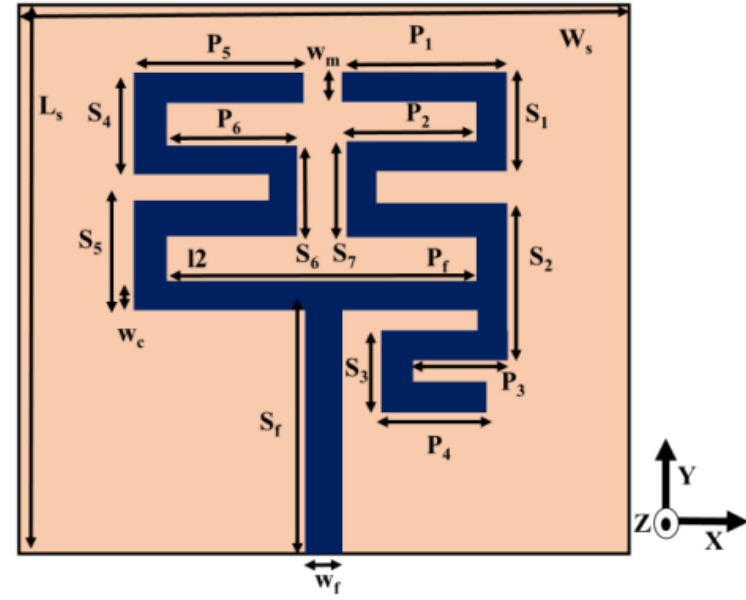
Figure 2. Schematic diagram of single unit quad band meander-line antenna.